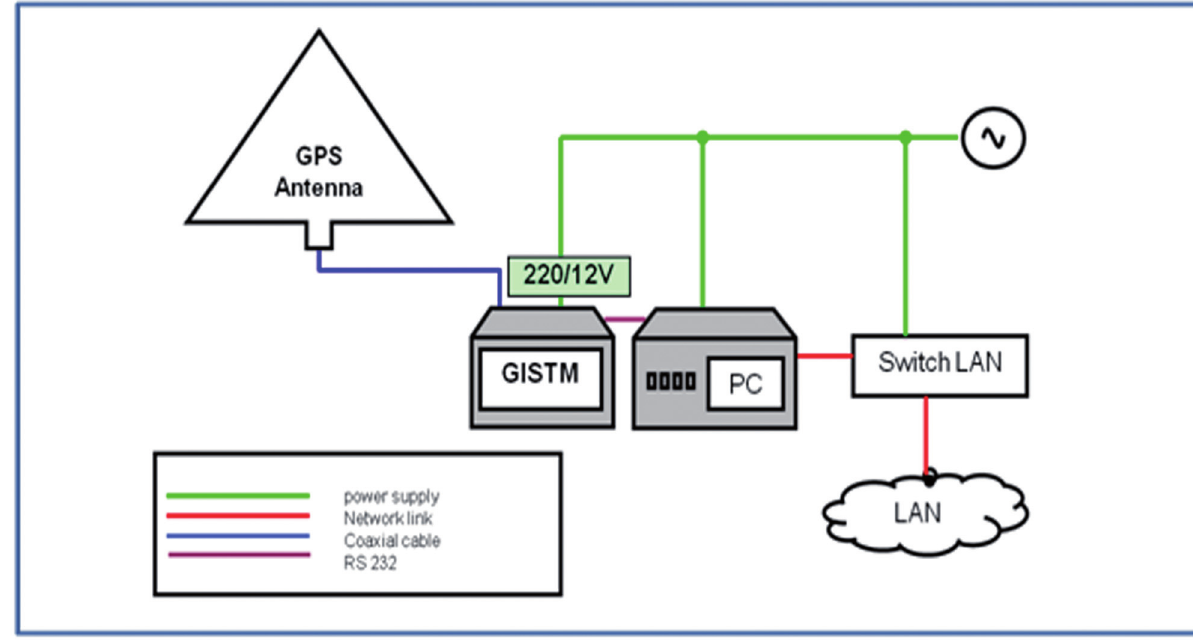
Figure 2. The ISACCO-DMC0 and DMC1 station block